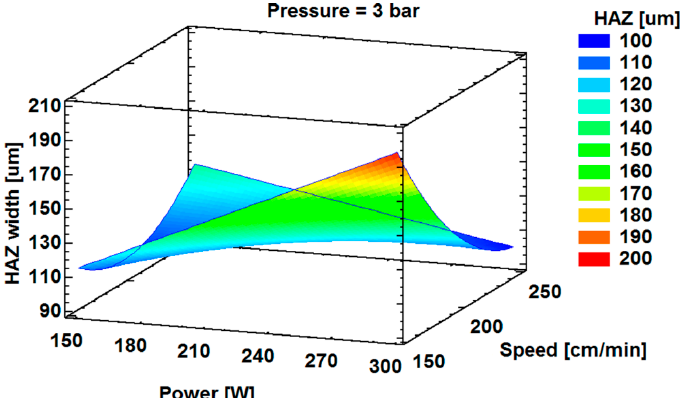
Figure 13. Response surface plot for the effects of the cutting parameters on HAZ width. Oxygen pressure 3 bar.